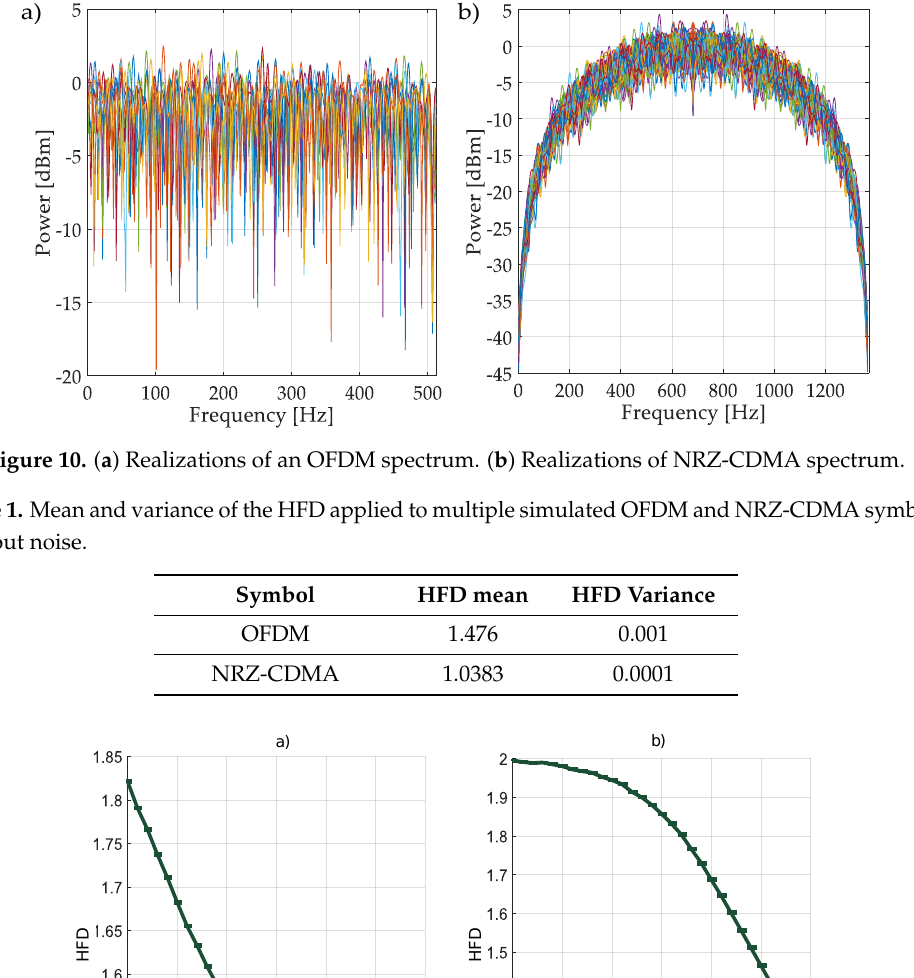
Figure 12. A real spectrum (in red) and the approximated signals from MRA using a Daubechies wavelet family. 4.2. Simulated Signals Both methodologies proposed in this paper were applied to a global simulation of 750,000 frames for each SNR value, varying in the interval [ − 10,20] dB and spaced by 2, as it is shown in Figure 13. In each frame, the number, type (OFDM or NRZ associated with CDMA), and position (frequency edges) of simulated symbols were generated randomly. Each frame consists of 1000 samples spaced by 0.1 MHz (i.e., an entire band of 100 MHz). Simulation parameters are summarized in Table 2. In Figure 13, three analysis blocks are added: studies of noise, symbols, and frequency edges. These